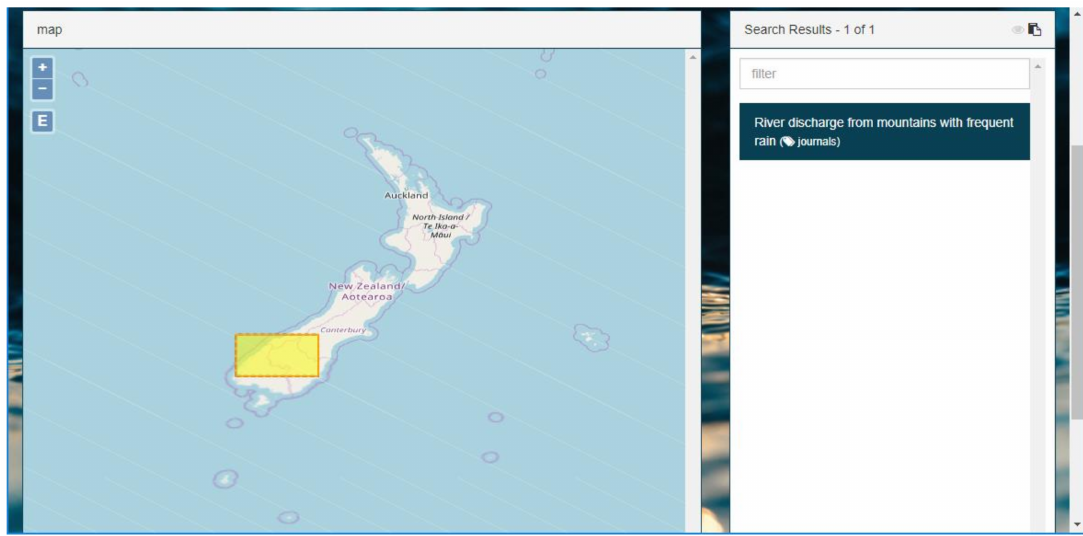
Figure A1. The geographic bounding box for the examplary metadata record of Appendix B as reported from the CSW